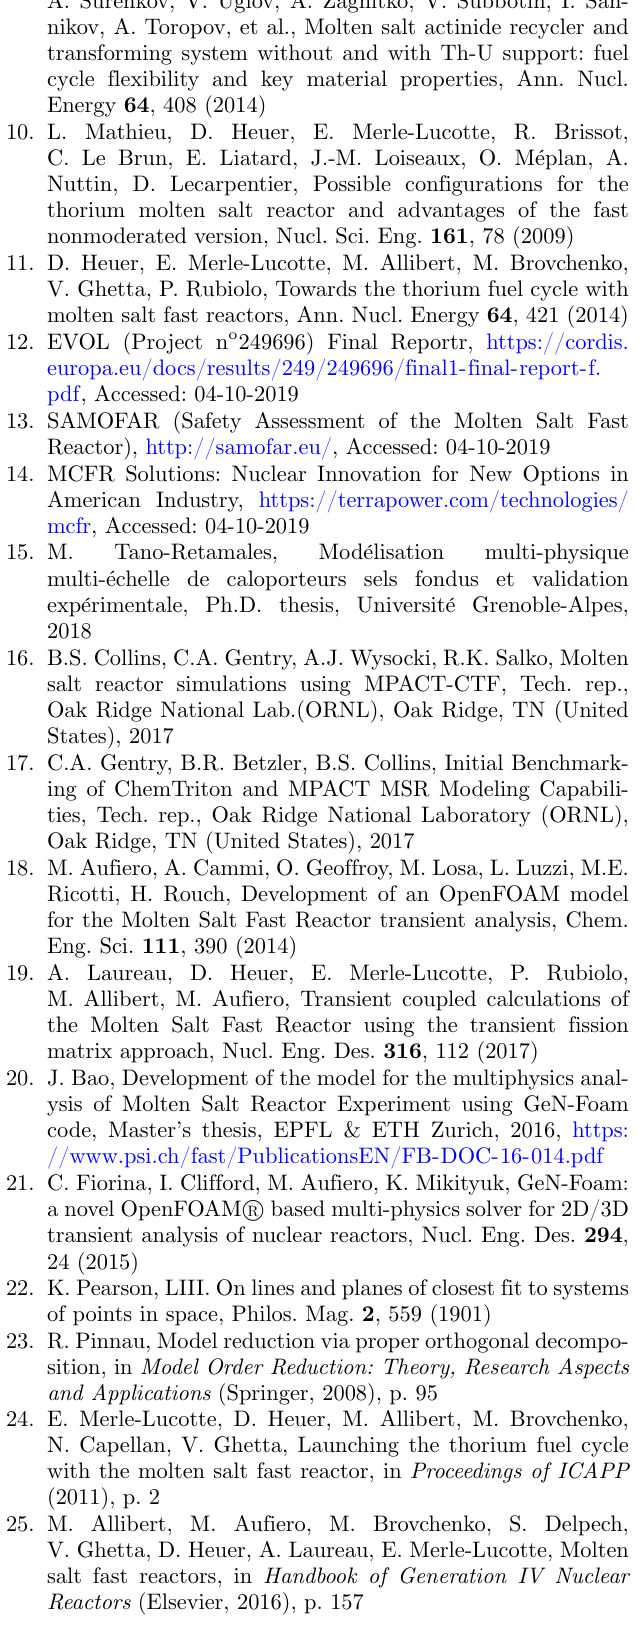
Table 3. The dimensions of the sub-spaces used in the